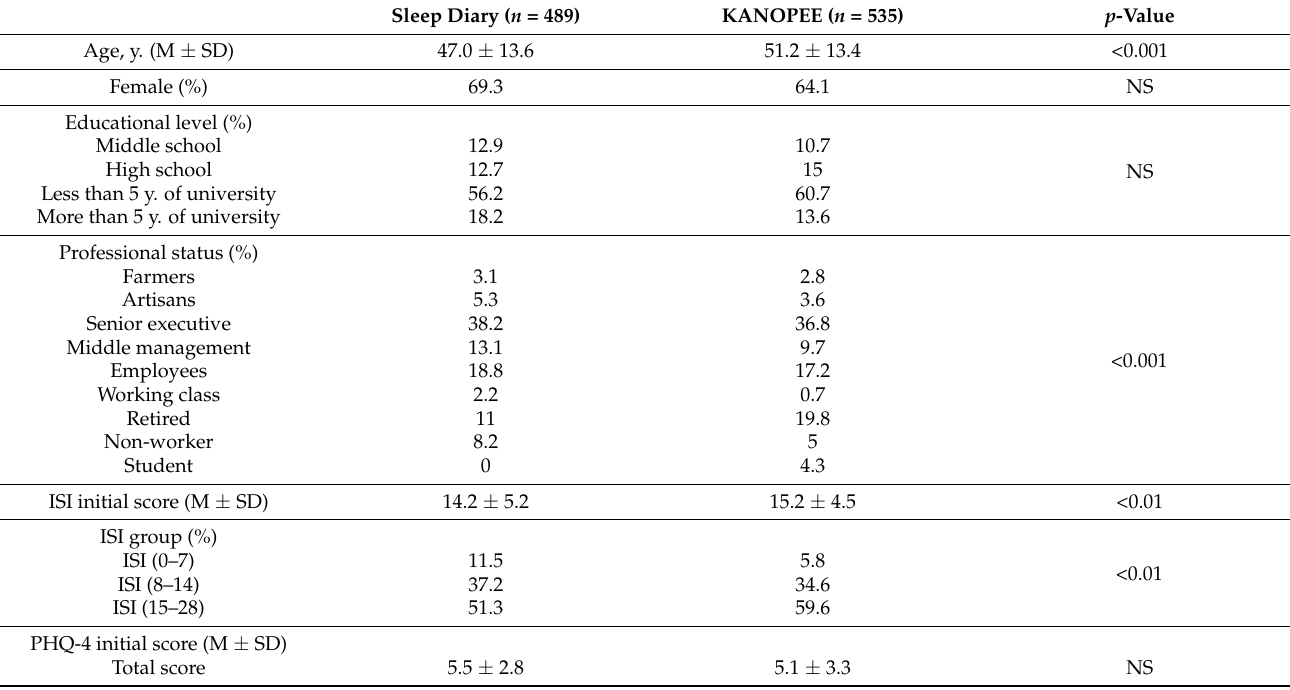
Table 1. Socio-demographic and clinical characteristics of participants.